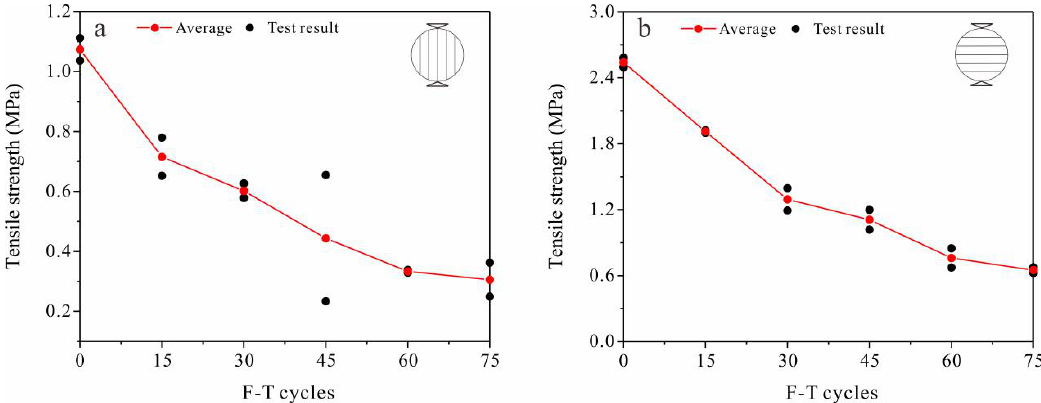
Figure 2. Variations in tensile strength with F-T cycles in sandstone samples with loading directions ( a ) parallel (S par ) and ( b ) perpendicular (S per ) to the bedding.